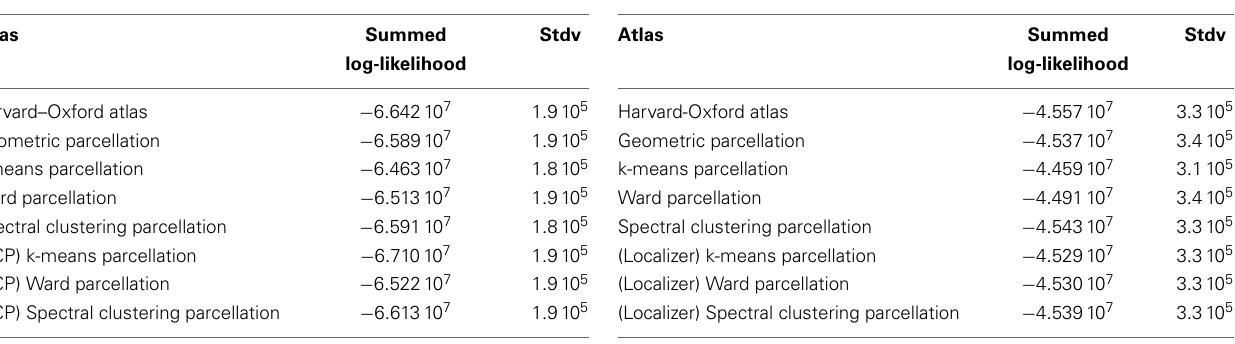
spatial models (the higher, the better): brain atlas (left), parcellation on the HCP dataset (middle), parcellations from the Localizer data (right).